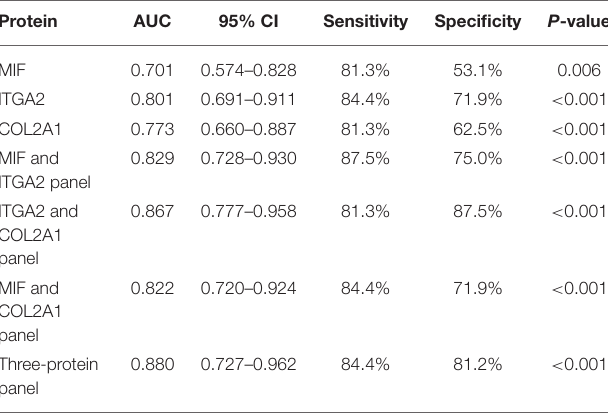
TABLE 3 | ROC curve analysis of the diagnostic ability of MIF, ITGA2, and COL2A1 in the validation phase.